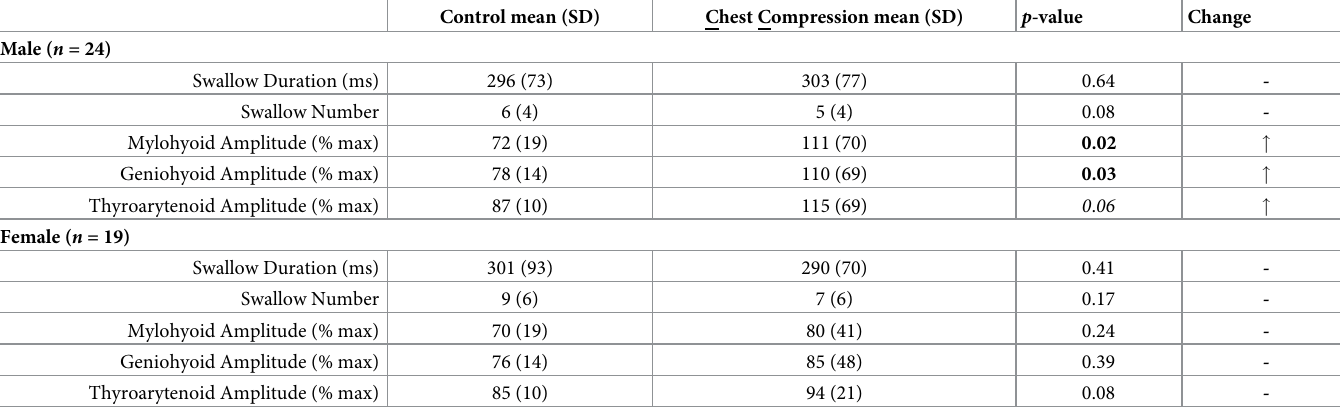
Table 1. Means, Standard Deviation (SD), p -values, and direction of change for swallow parameters during control and chest compression conditions for both male and female groups. Amplitude is normalized to maximum of control and shown as a percentage. Control mean (SD) Chest Compression mean (SD) p -value